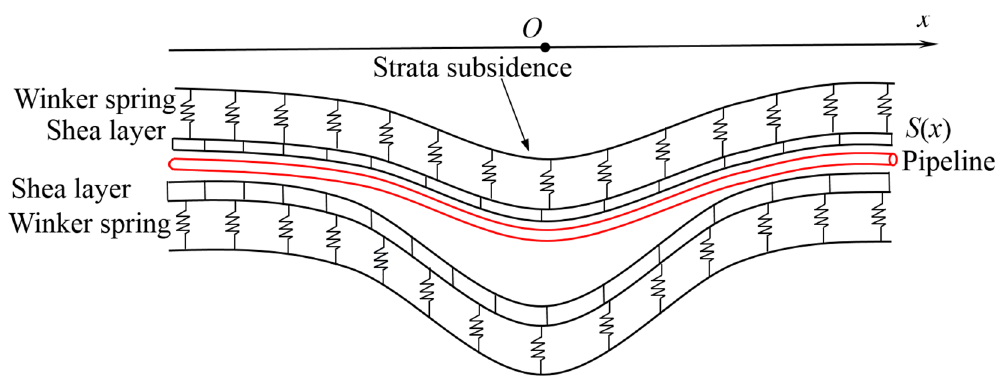
Figure 3. Pipeline-soil interaction